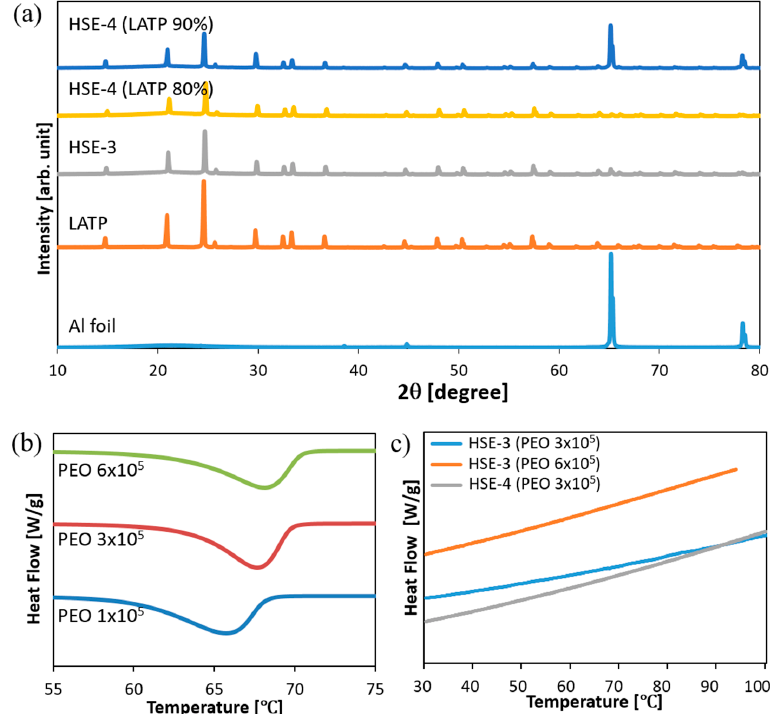
Figure 5. ( a ) XRD Patterns of LATP, HSE ‐ 3, HSE ‐ 4 ( b ) DSC of PEO with different molecular weight 1 × 10 5 , 3 × 10 5 and 6 × 10 5 ( c ) DSC of HSE ‐ 3 (PEO 3 × 10 5 ), HSE ‐ 3 (PEO 6 × 10 5 ) and HSE ‐ 4 (PEO 3 × 10 5